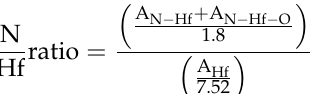
Figure 4. Raman spectra of HfN thin films prepared by RGT and conventional mixture gases tech- niques.